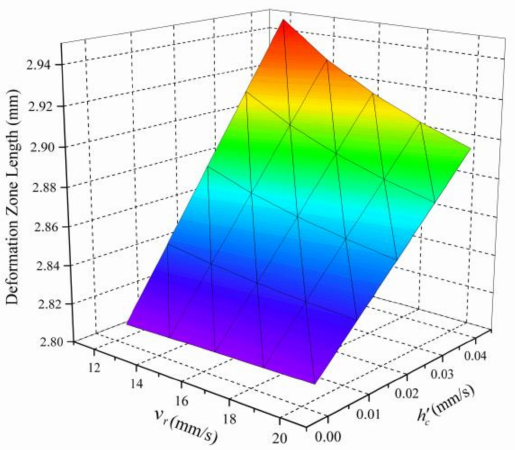
Figure 11. The influence of rolling velocity and roll gap reduction velocity on the deformation zone length (2 h 1 = 1.816 mm).